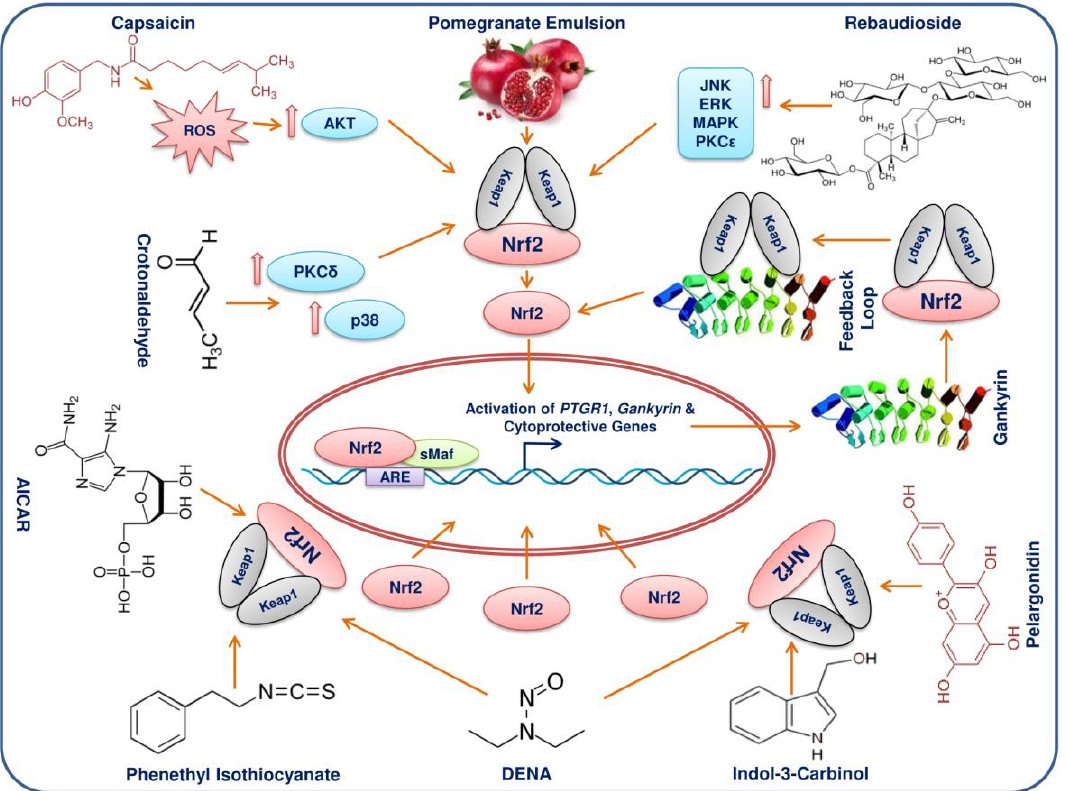
Figure 5. Phytochemicals and molecules that activate Nrf2 in HCC. Phytochemicals trigger the transcriptional activation of Nrf2 target genes by activating Nrf2 through different